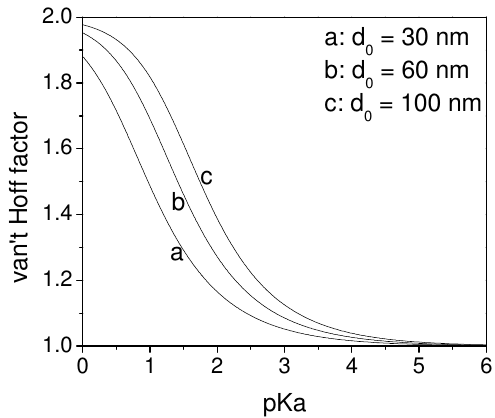
Fig. 8. Van’t Hoff factor as a function of pK a at the critical droplet diameter of three particles with different dry sizes, composed of a model monovalent acid with molar mass M =150g/mol and density ρ